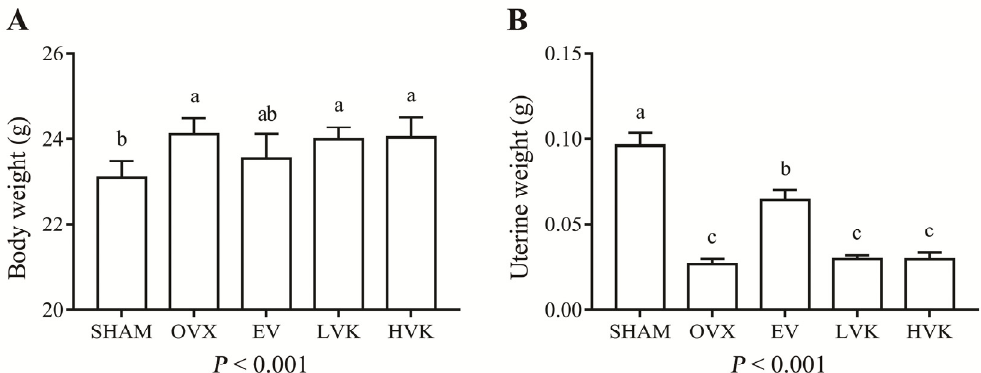
Figure 1. Body ( A ) and uterine ( B ) weights in mice that were sham operated or ovariectomized and untreated or administered EV, LVK, or HVK for 12 weeks. Values are mean ± SD, n = 8–10 per treatment. Labeled without a common letter means a significant difference, p < 0.05. EV, estradiol valerate; HVK; MK-4 40 mg/kg body weight group; LVK, MK-4 20 mg/kg body weight group; MK-4, menaquinone-4; OVX, ovariectomized group; SD, standard deviation.